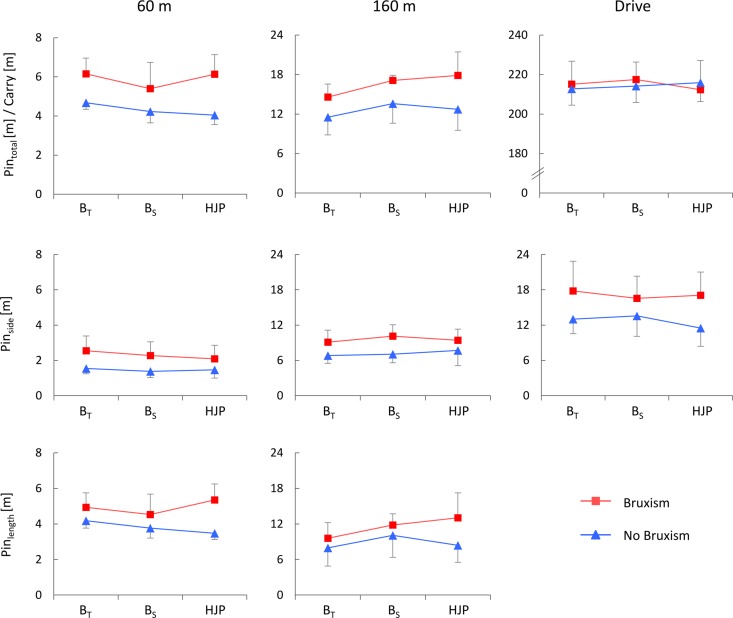
Performance variables for 60, 160 m, and Drive distance as functions of oral motor tasks and sleep bruxism. Pintotal = total distance to pin; Carry = shot length; Pinside = lateral distance to pin; Pinlength = longitudinal distance to pin; BT = biting on teeth; BS = biting on splint; HJP = habitual jaw position.